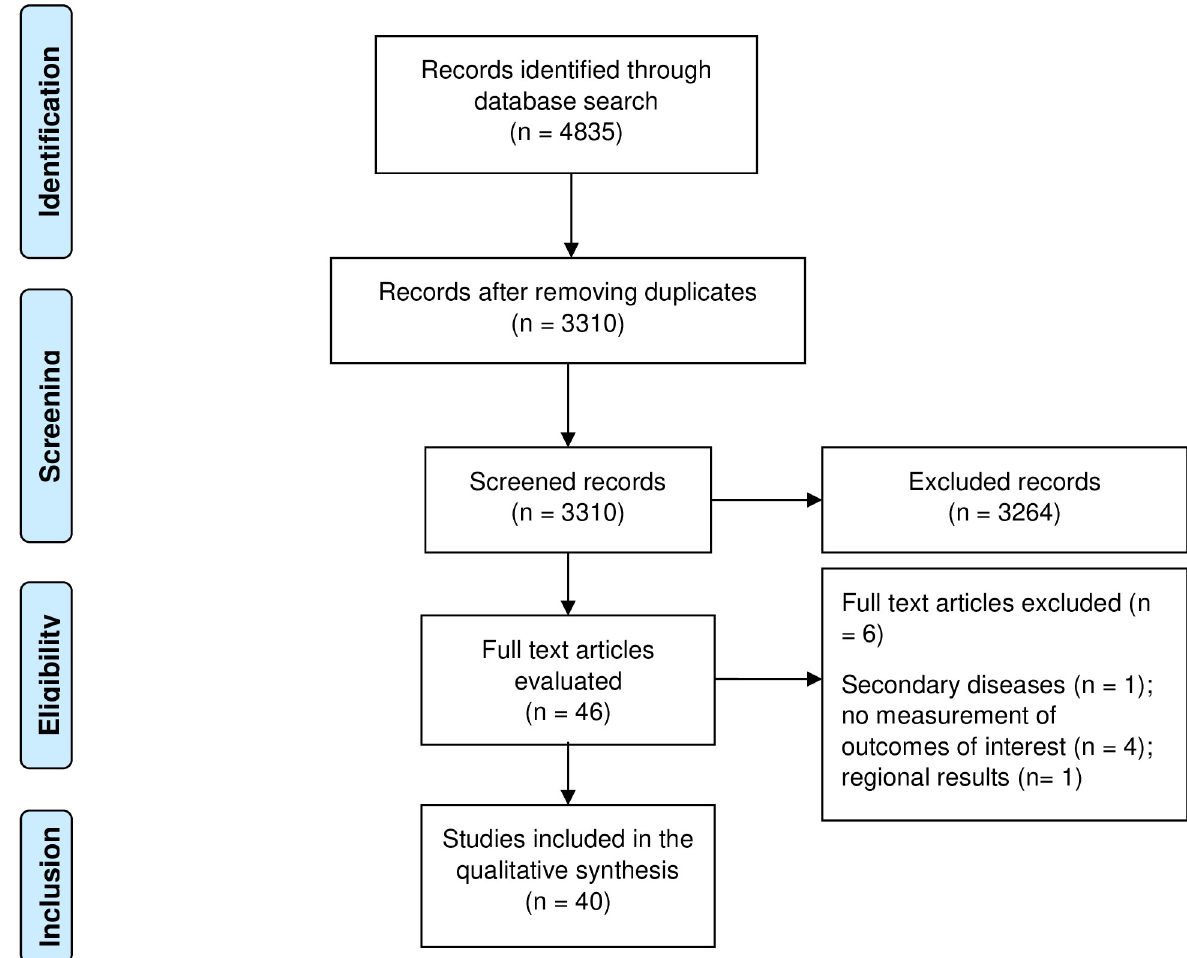
Fig 1. Flow chart of study selection according to the PRISMA